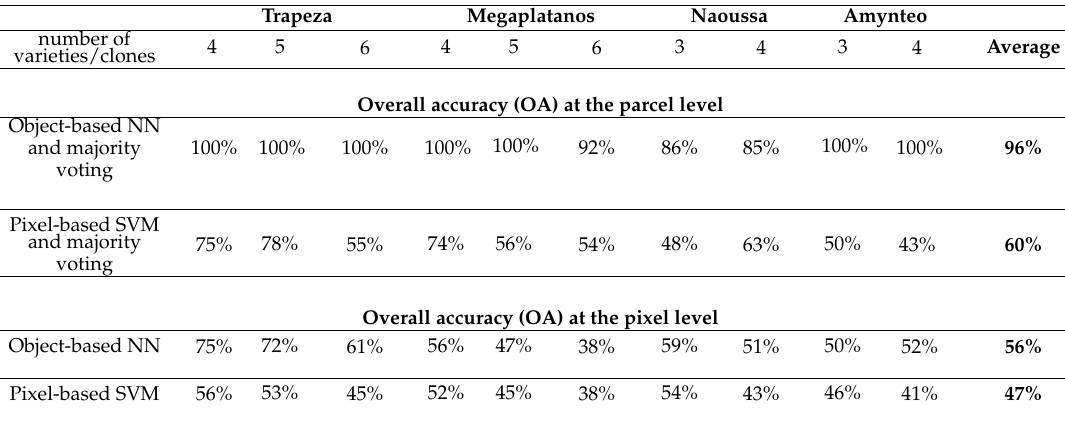
Table 6. Comparing results from the proposed object-based NN framework with a pixel-based SVM classifier for the variety discrimination task. Trapeza Megaplatanos